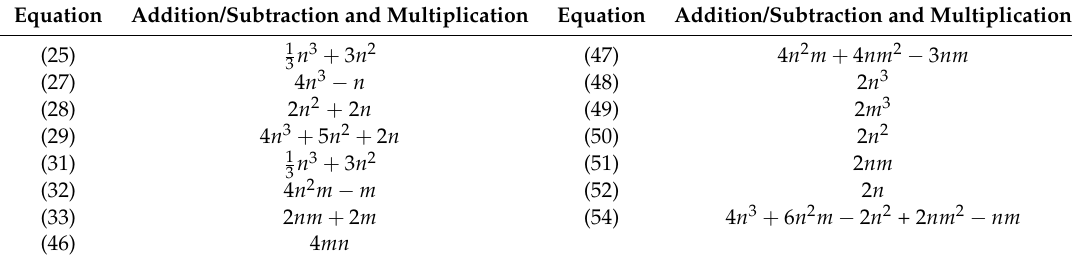
Table 1. Computational complexities of some equations, where n denotes the dimension of the state variable, m denotes the dimension of the